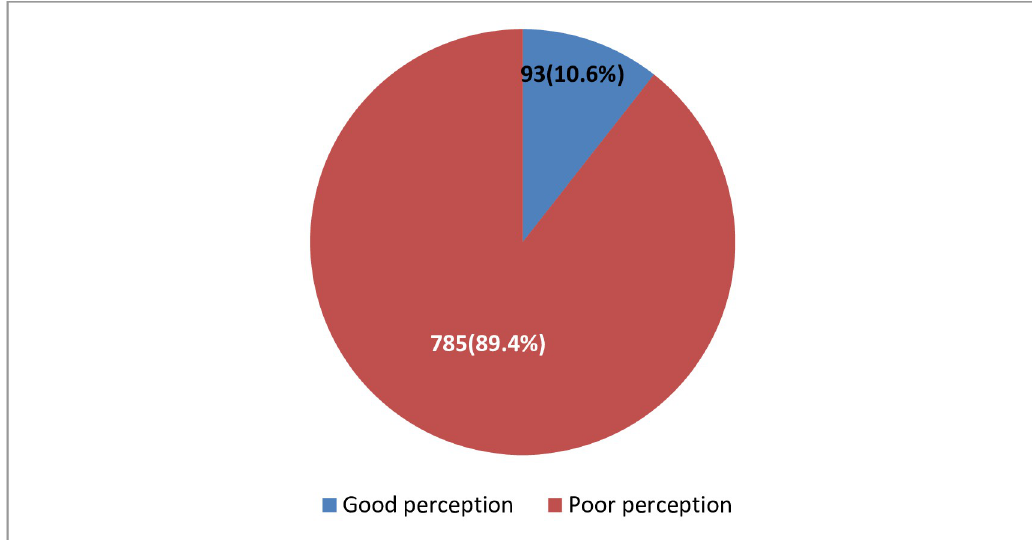
Fig 1. Perception of respondents regarding COVID-19